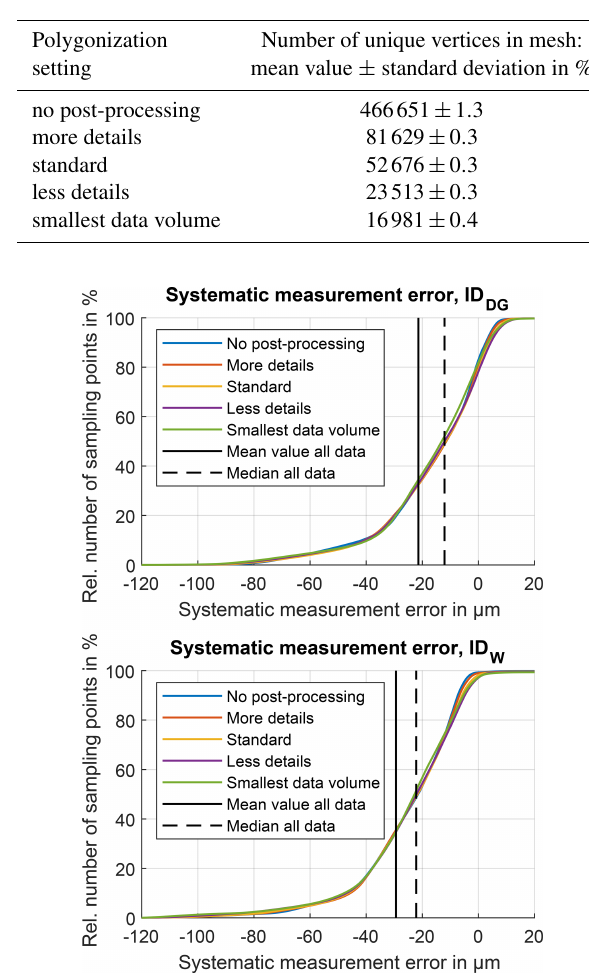
Figure 8. Cumulative visualization of the systematic measurement errors for different polygonization settings for both gear wheels ID DG and ID W .